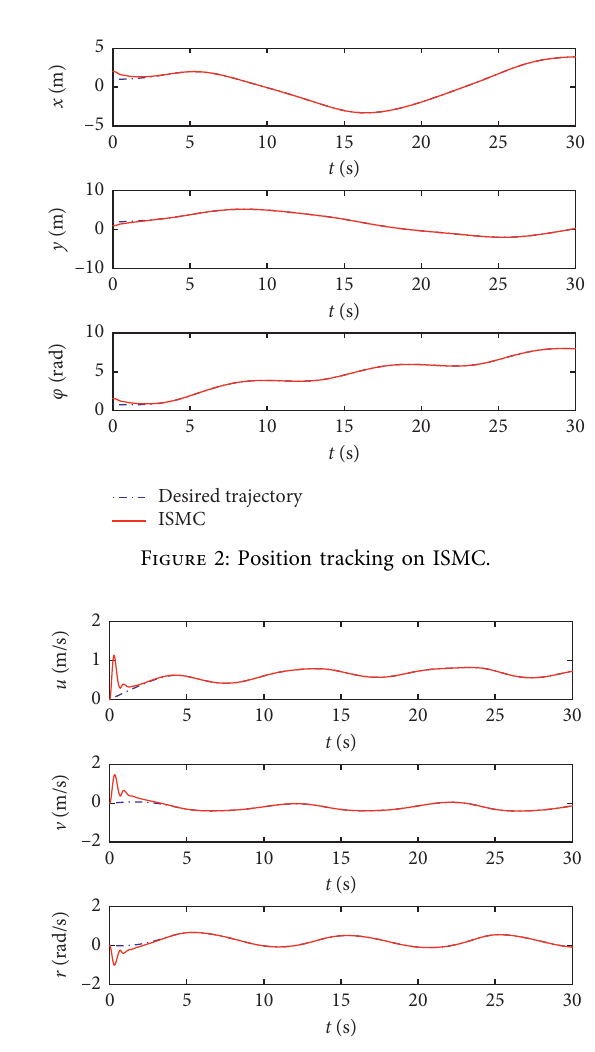
Figure 1: Planar trajectory tracking on ISMC.